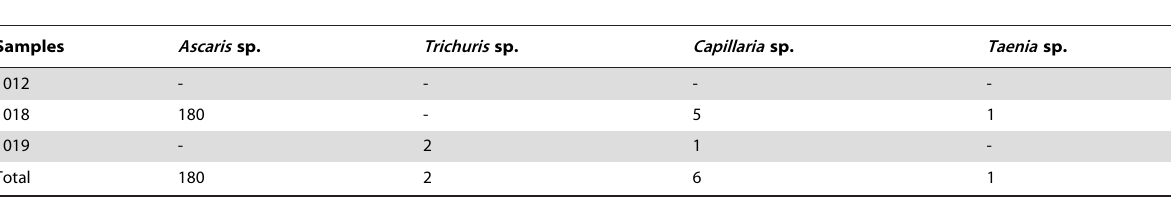
Values represent the number of egg after the analysis of ten slides.